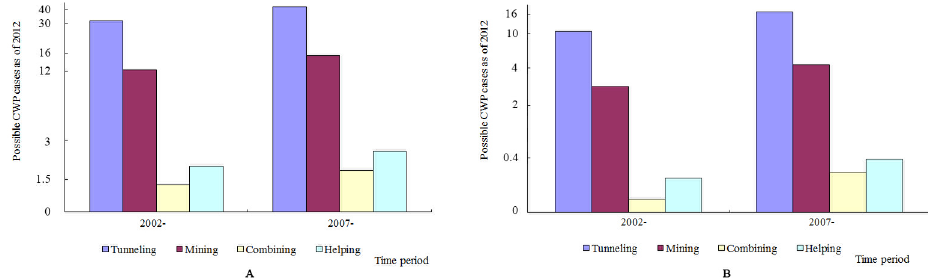
Fig 1. Possible CWP cases among redeployed coal workers by time period as of 2012. A: Possible CWP cases among redeployed coal workers of 1965-; B: Possible CWP cases among redeployed coal workers of